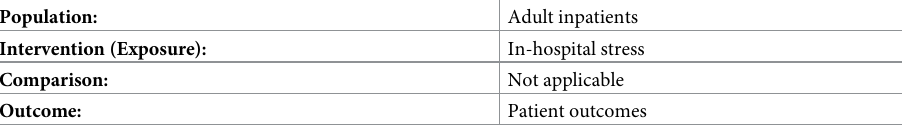
Table 1. PICO framework used to formulate search